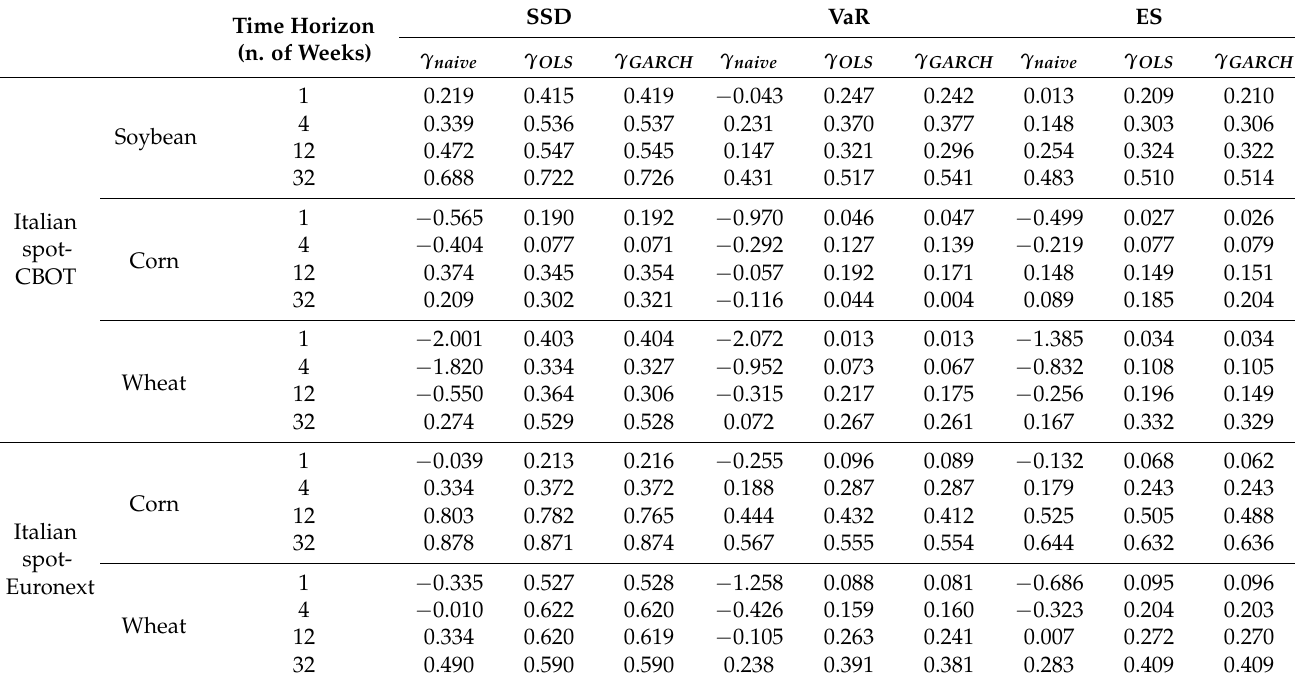
Table 4. Estimates of the Hedging Effectiveness through risk indexes, for all the considered